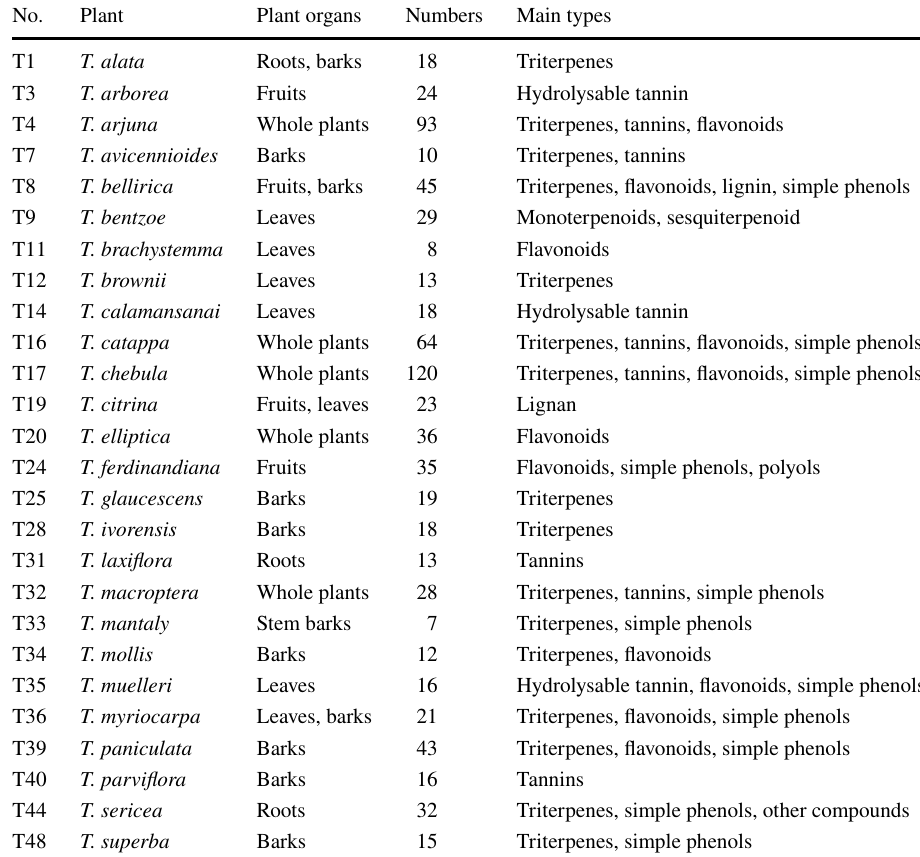
Table 3 The numbers and main types of compounds reported from different Terminalia